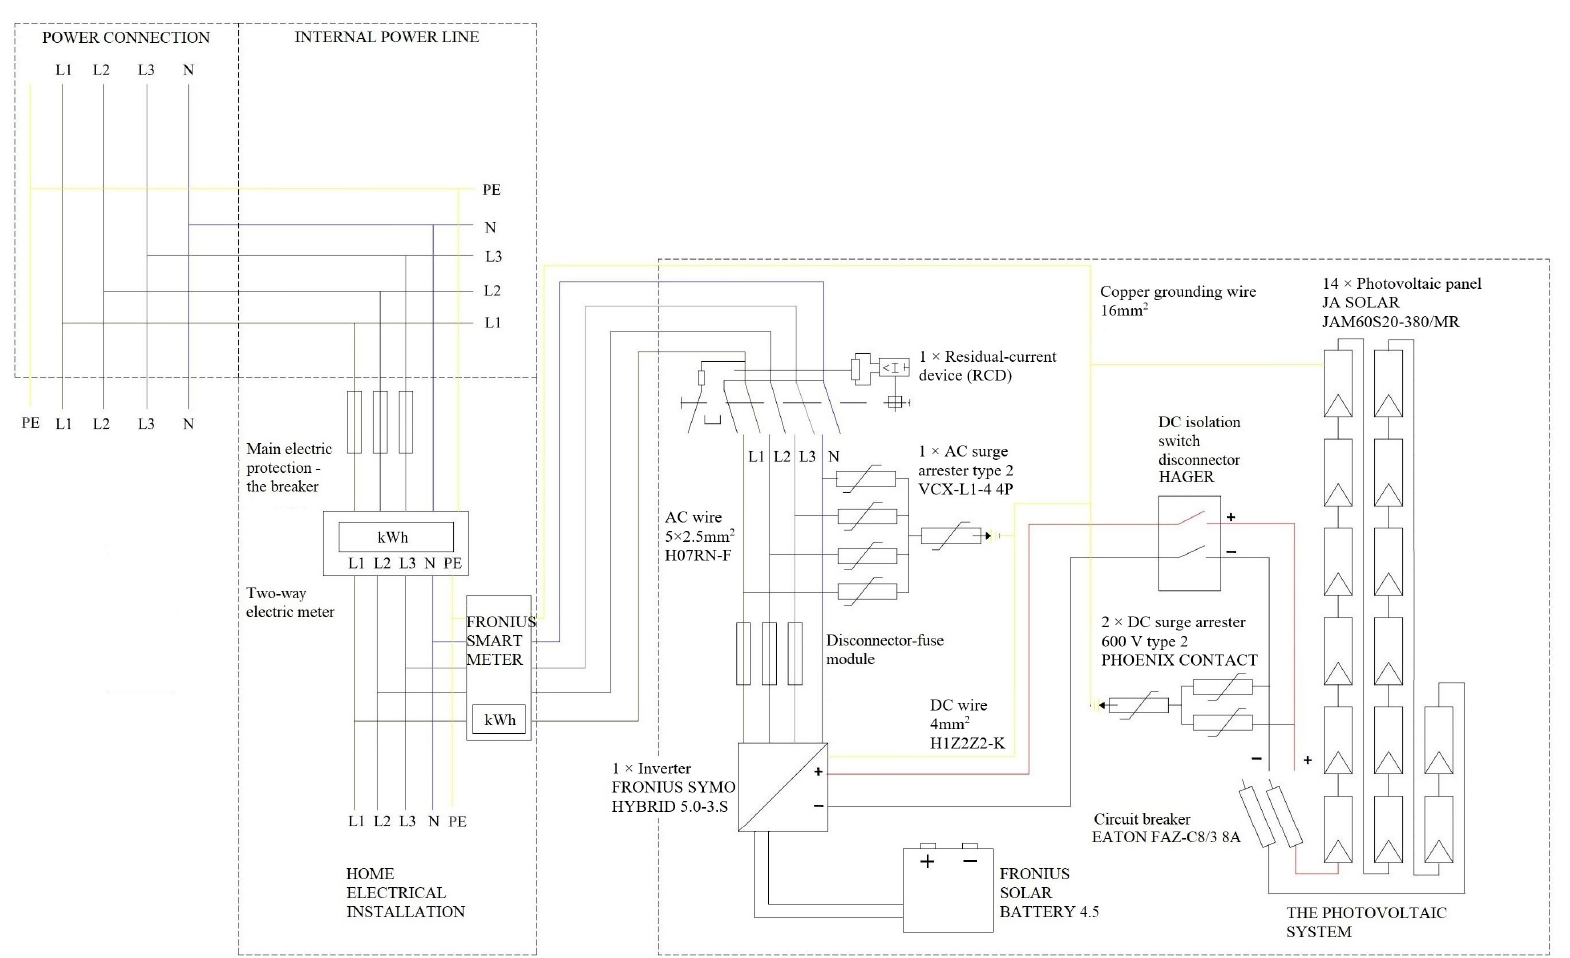
Figure A2. Electrical diagram of the designed photovoltaic installation extended by an energy storage and energy management system.